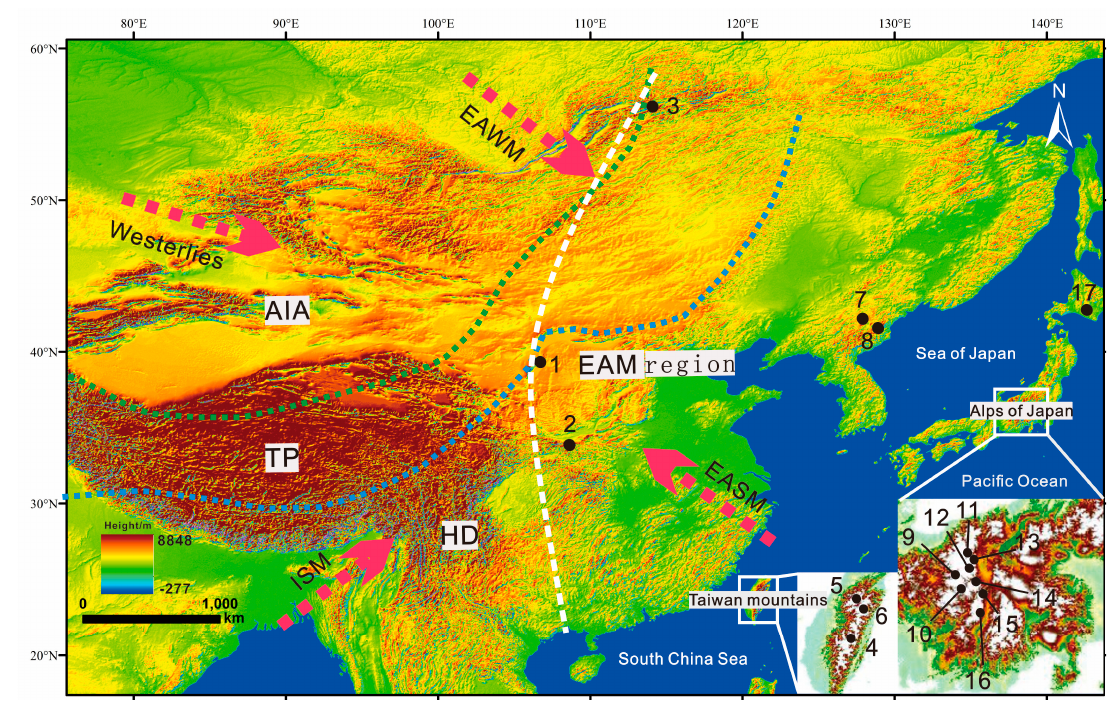
Figure 1. Location of the glaciated mountains in the study area DEM. Green dotted lines represent the present limits of monsoonal precipitation, blue dotted lines represent the LGP limits of monsoonal precipitation. East of white dotted lines represent the study area, lines reference from [22]. 1: Helan